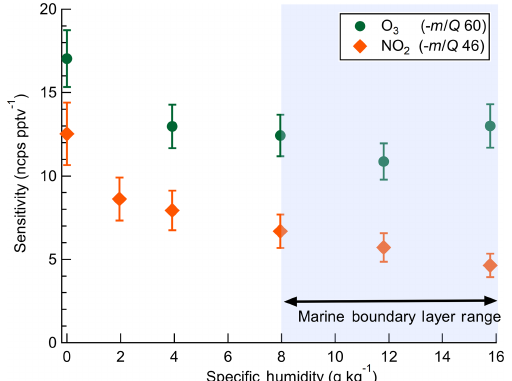
Figure 3. Dependence of O 3 and NO 2 sensitivities on specific hu- midity. Error bars indicate standard deviation of triplicate calibra- tion curves. The shaded blue region of SH 8–16gkg − 1 is the ap- proximate typical range of specific humidity in the midlatitude ma- rine boundary layer.